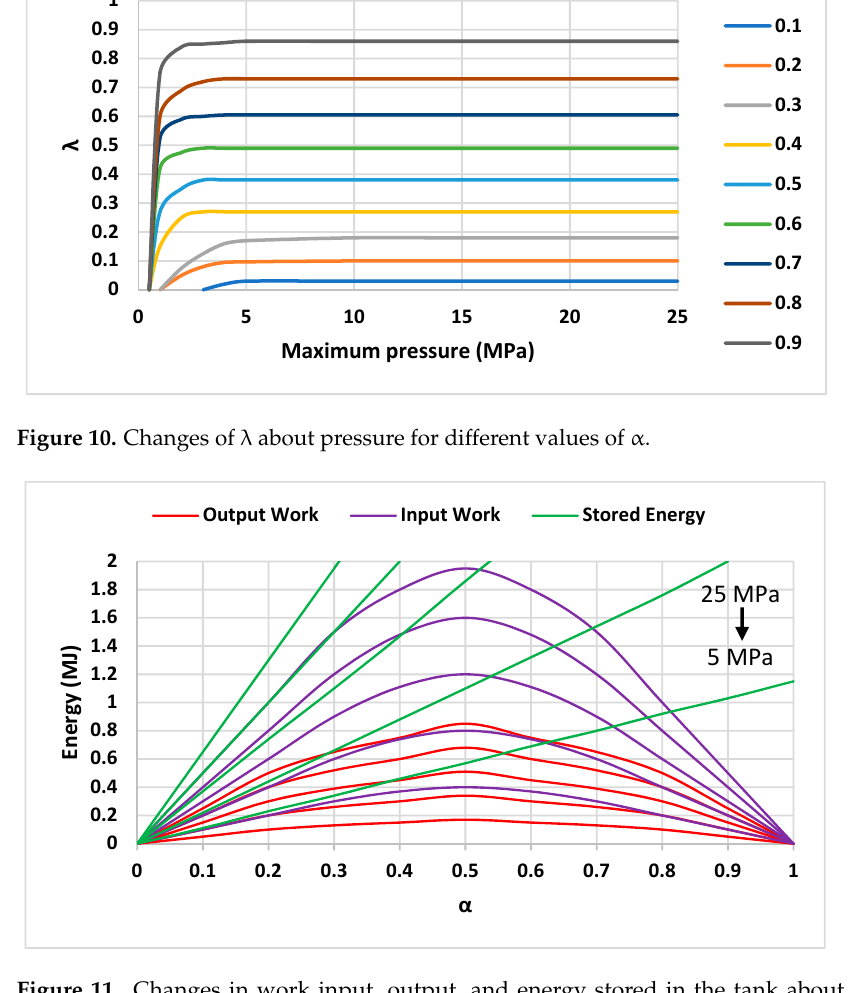
Figure 11. Changes in work input, output, and energy stored in the tank about α for different pressures and specific tank volume (1000 m 3 ).